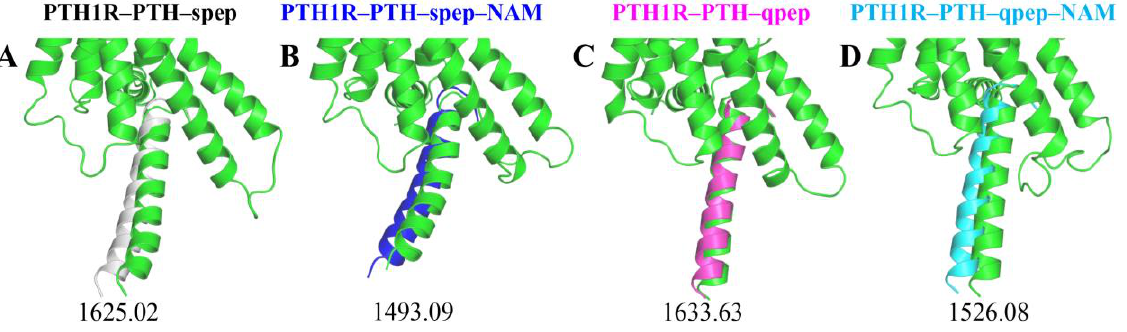
Figure 6. Cartoon illustration of the predicted spep/qpep position of each system in ZDOCK. ( A ) PTH1R–PTH–spep system; ( B ) PTH1R–PTH–spep–NAM system; ( C ) PTH1R–PTH–qpep system; and ( D ) PTH1R–PTH–qpep–NAM system. The representative conformation of the predominant cluster during the last 300 ns in each system is shown in green. The numbers below correspond to the ZDOCK binding score.